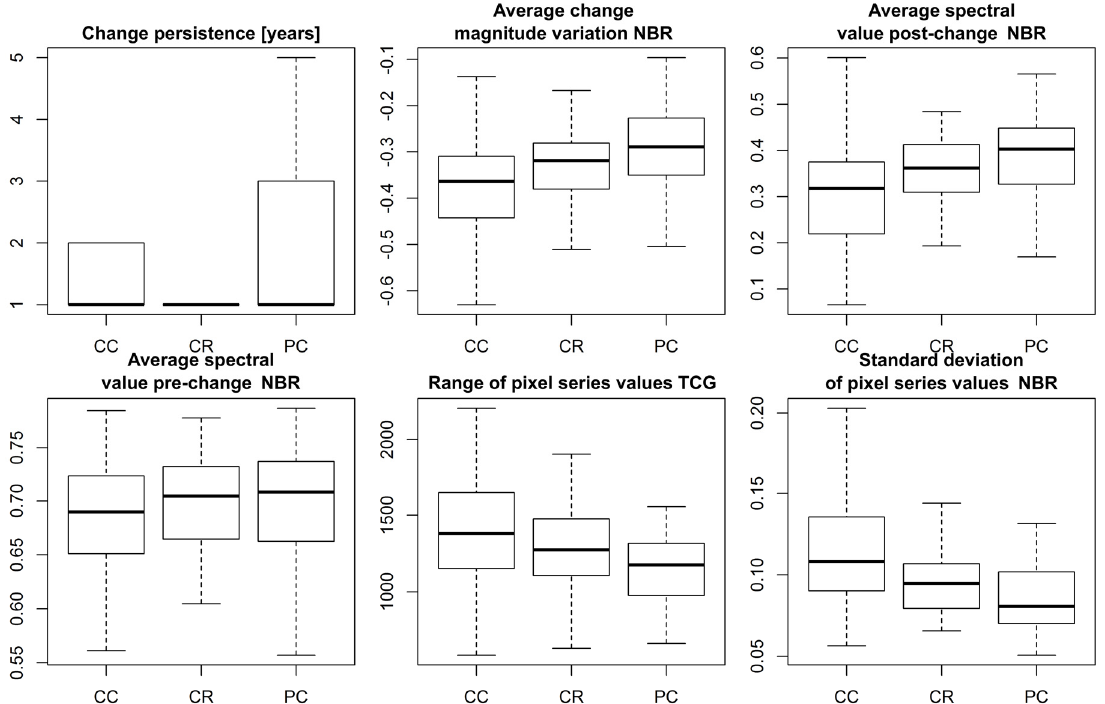
Figure 5. Boxplots representing median, interquartile range, and extreme values for selected Landsat-derived spectral metrics across harvest practices: clearcut (CC), clearcut with residual (CR), and partial cut (PC). Note that outliers are not displayed. Table 1. Statistically significant different groups determined with Tukey’s post hoc test ( p < 0.05). Metric Clearcut Clearcut with Residual Partial Cut